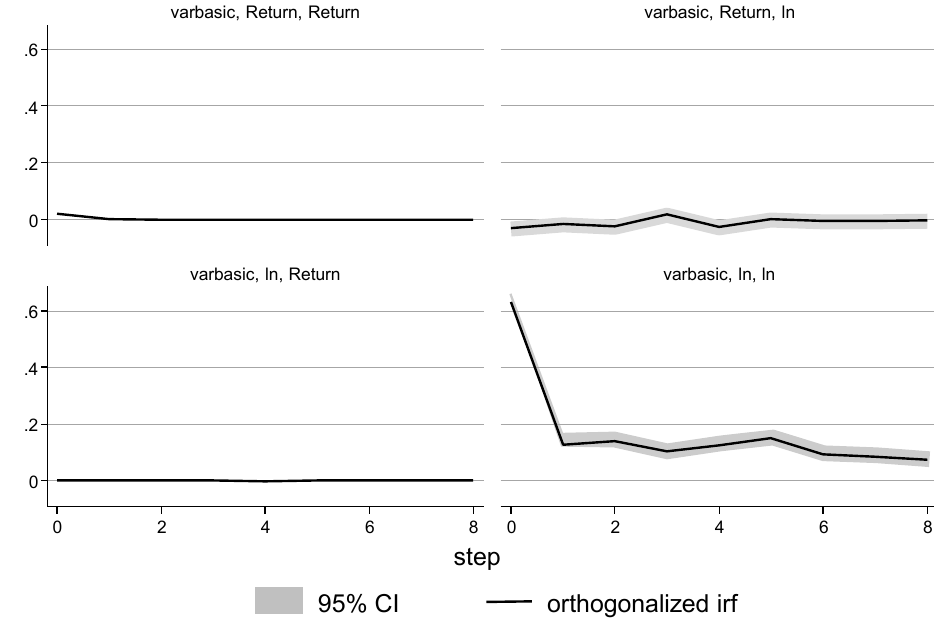
Figure 5. Orthogonalized impulse-response function (VAR with 13